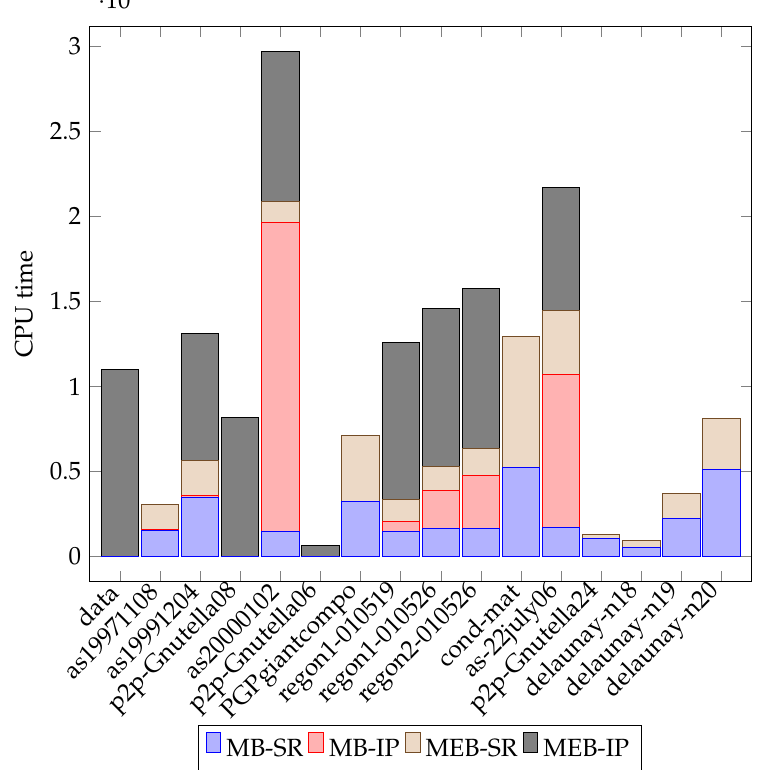
Figure 3. Illustration of the CPU times used by the scale reduction and the IP solution for the MB problem (MB-SR and MB-IP, respectively) and for the MEB problems (MEB-SR and MEB-IP, respectively). The respective CPU times are plotted for all the tested instances for which at least one of the four times exceeded 500